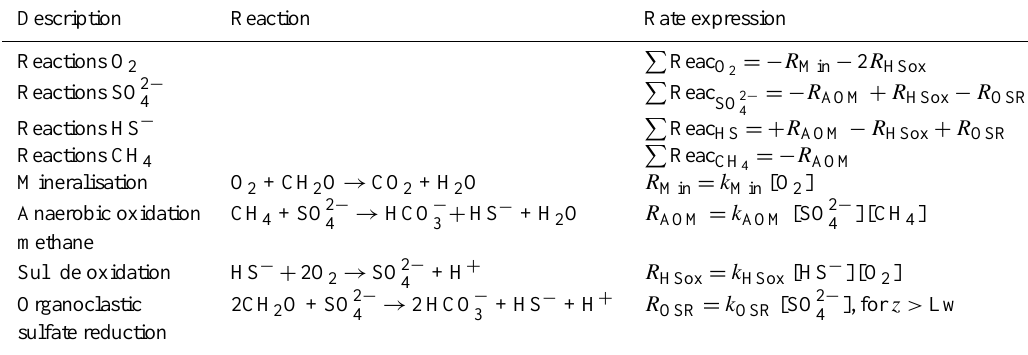
Table 2. Model formulations and reactions; concentrations are denoted with brackets; CH 2 O represents organic matter, which is not explicitly